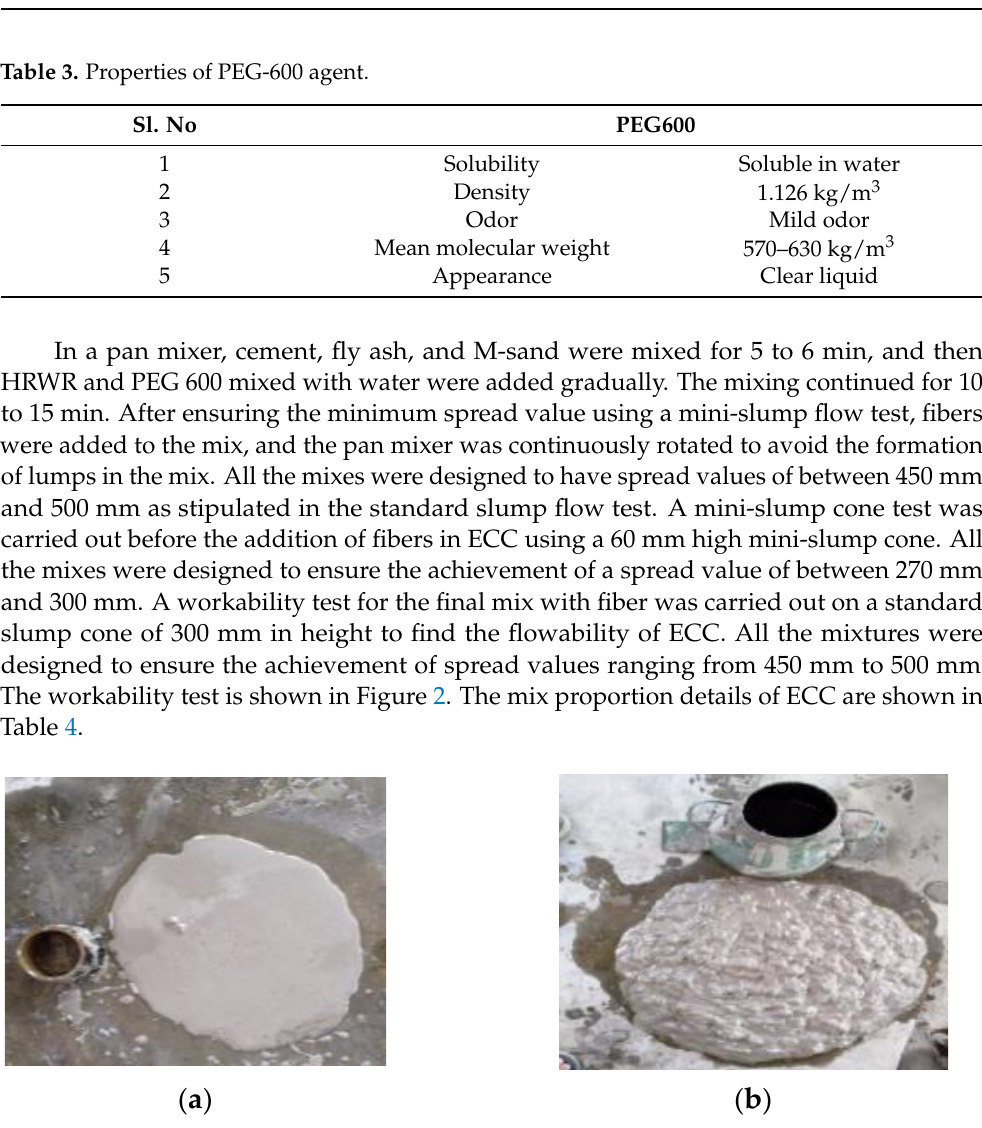
Figure 2. Workability test on ECC. ( a ) Mini-slump test; ( b ) standard slump test.